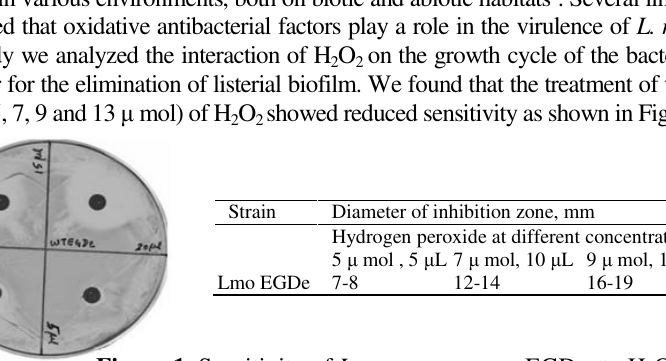
Figure 1. Sensitivity of L. monocytogenes EGD-e to H